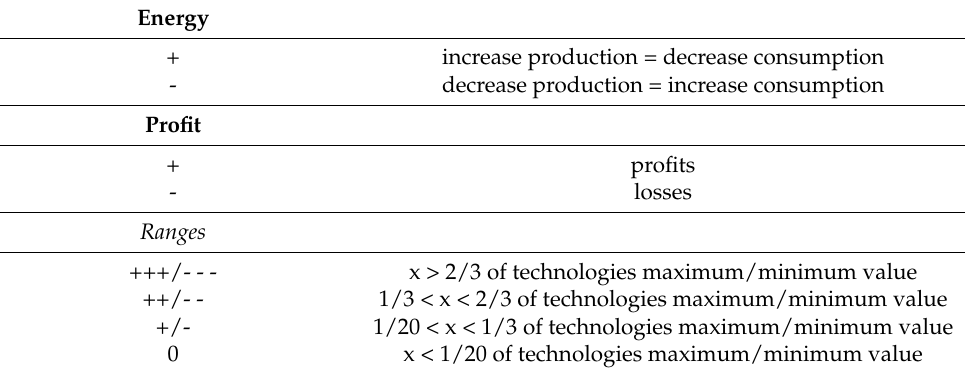
Table 14. Legend for Tables 12 and 13.